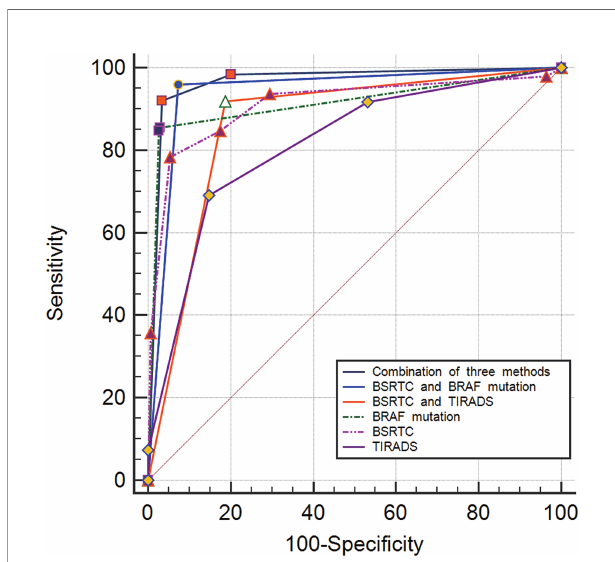
FIGURE 3 | Graph of receiver operating characteristic (ROC) analyses of different diagnostic methods for distinguishing between benign and malignant thyroid nodules.